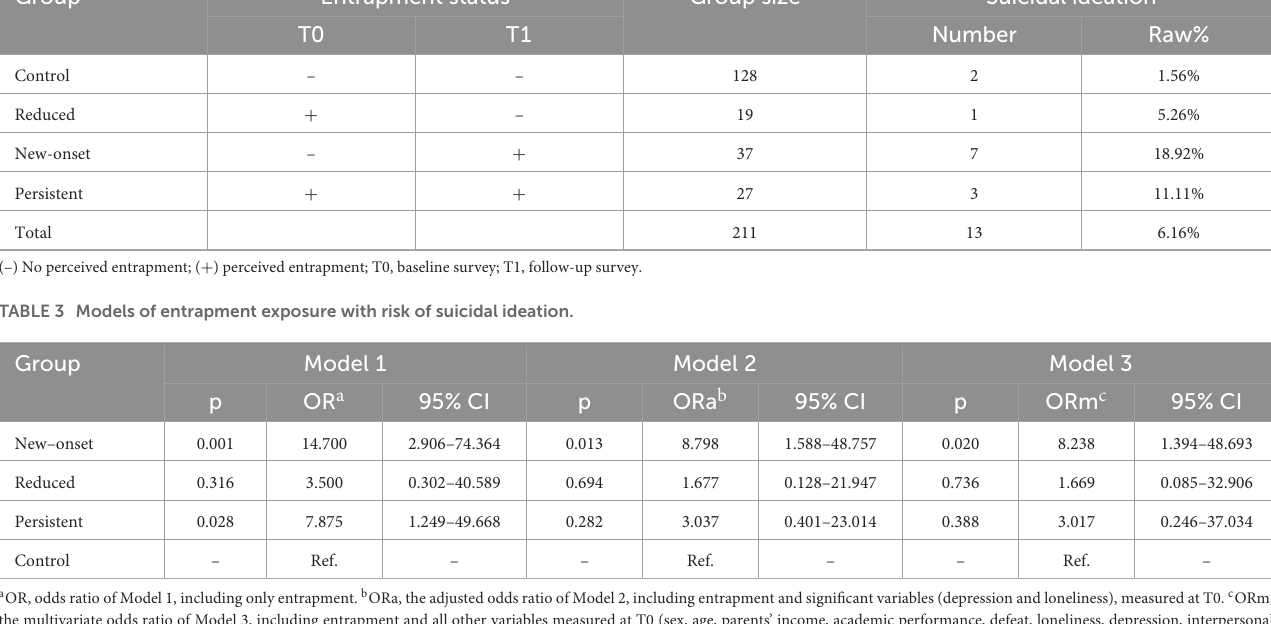
TABLE 2 Subgroup division and suicidal ideation in the four subgroups. Group